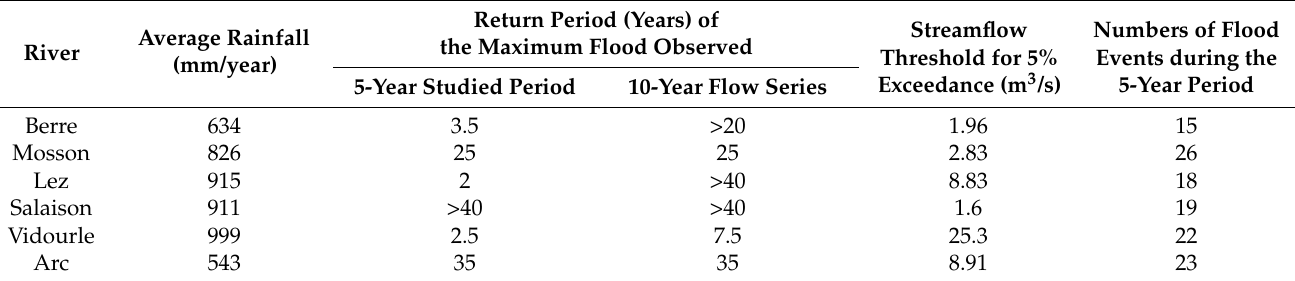
Table 3. Main hydrologic features of the six rivers.